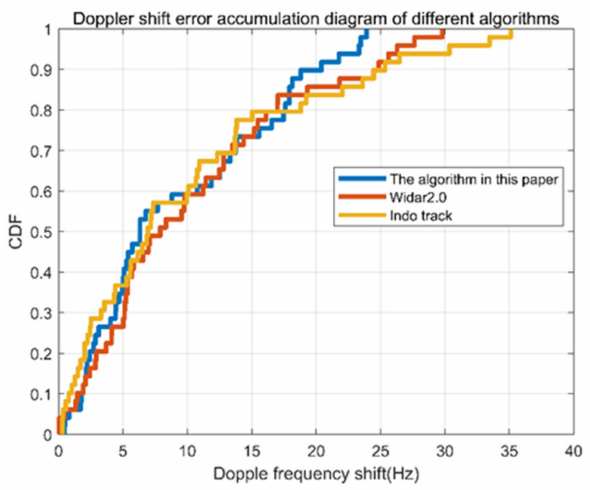
Figure 9. Error accumulation diagram of different algorithms.